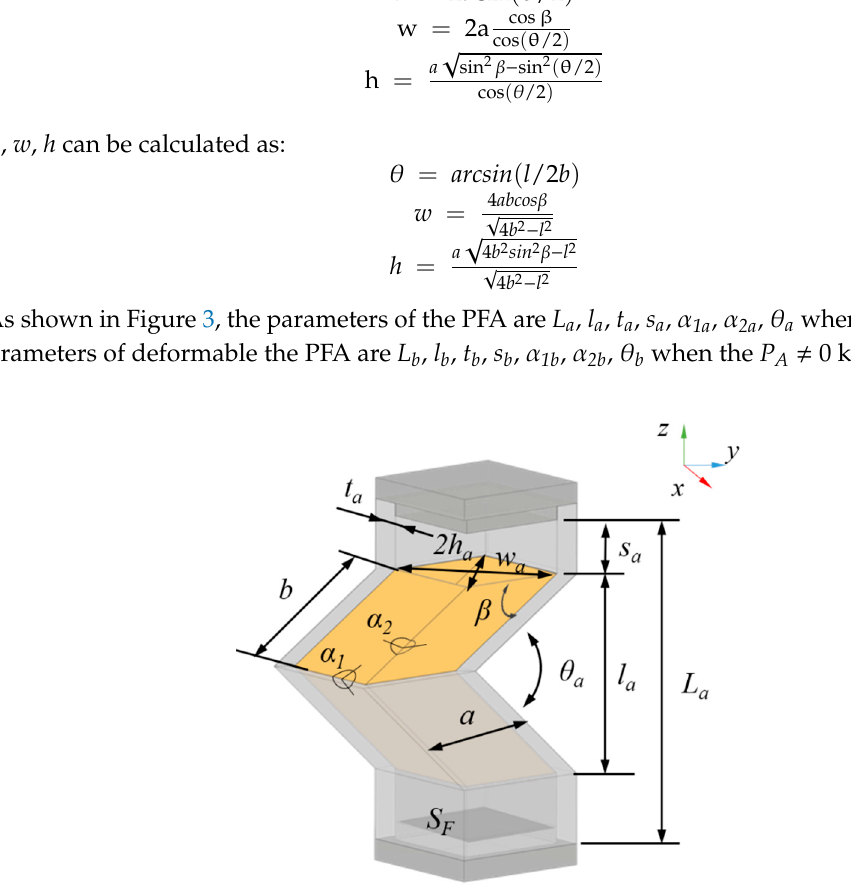
Figure 3. The parameters of the PFA when the P A = 0 kPa; the parameters of the PFA are L a , l a , t a , s a , α 1a , α 2a , θ a , and the parameters of the deformable PFA are L b , l b , t b , s b , α 1b , α 2b , θ b when the P A ≠ 0 kPa.